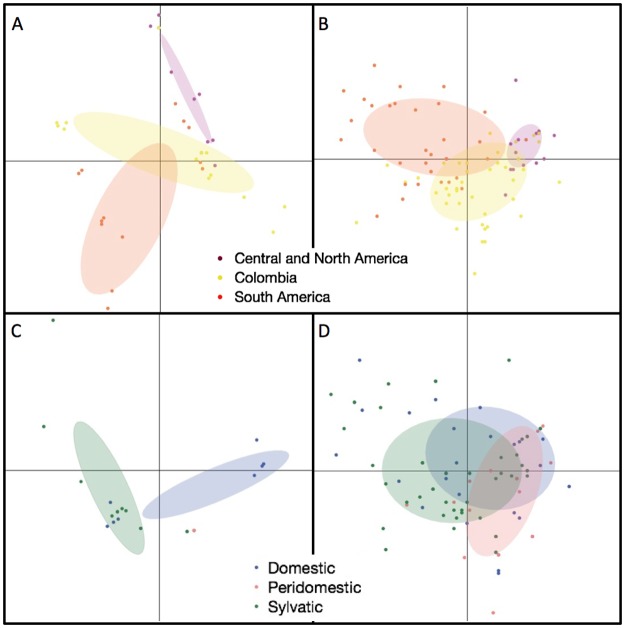
Principle component plots of variation in TcI isolates for the two markers by geographic region (A: 18S, B: SL-IR) and ecotope (C: 18S, D: SL-IR).Ellipses cover 50% of the variables. For geographic regions, both 18S and SL-IR are significantly different among regions. For ecotopes, the 18S sylvatic is significantly different from domestic, but for SL-IR, the differences are not statistically significant.